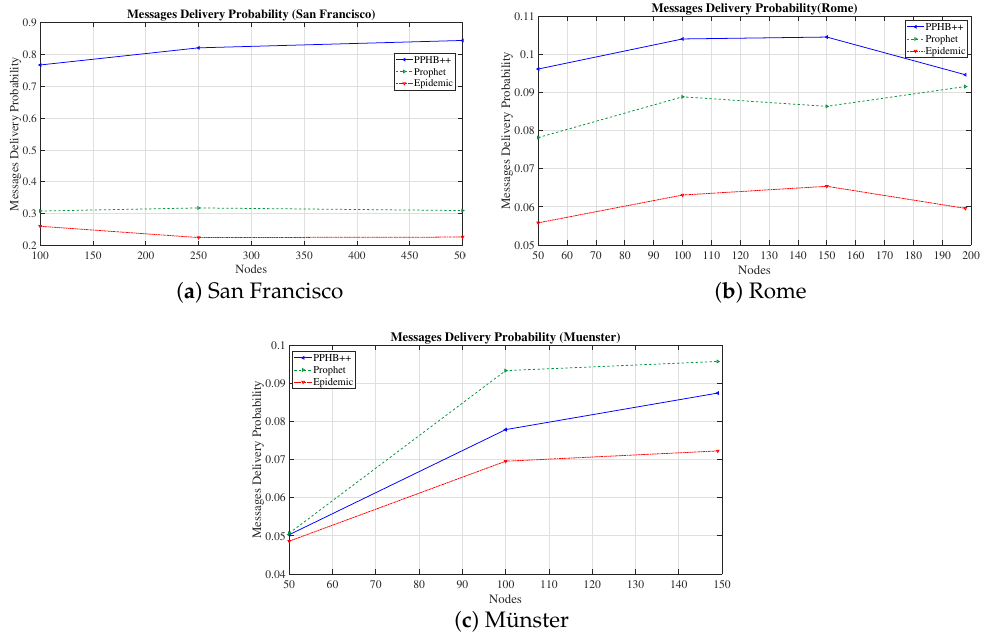
Figure 3. Messages delivery probability (MDP) for the three cities of San Francisco, Rome, and Münster (The y-axis parameter is normalized to a scale between 0 and 1).